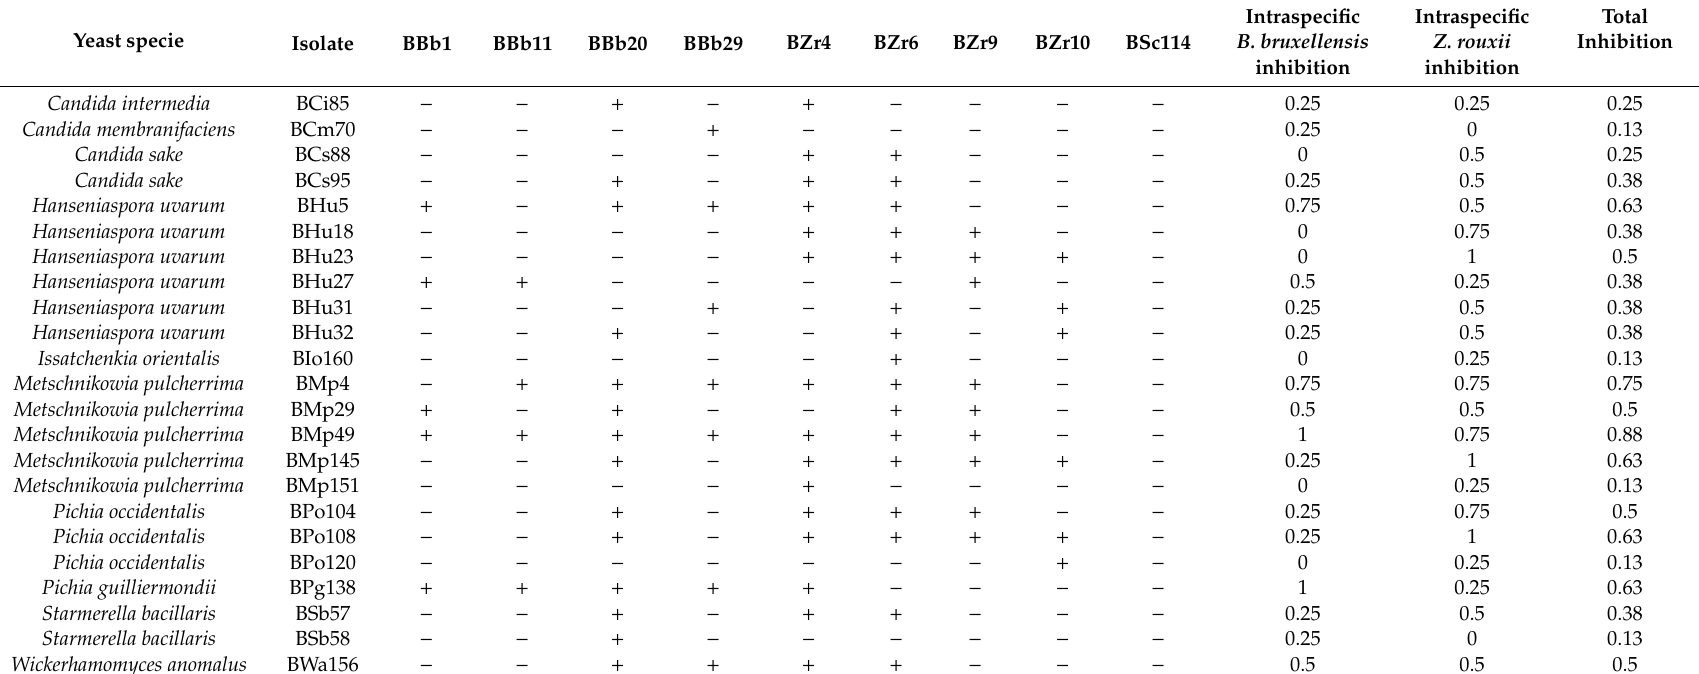
Table 2. Biocontrol of spoilage yeasts by non- Saccharomyces yeast